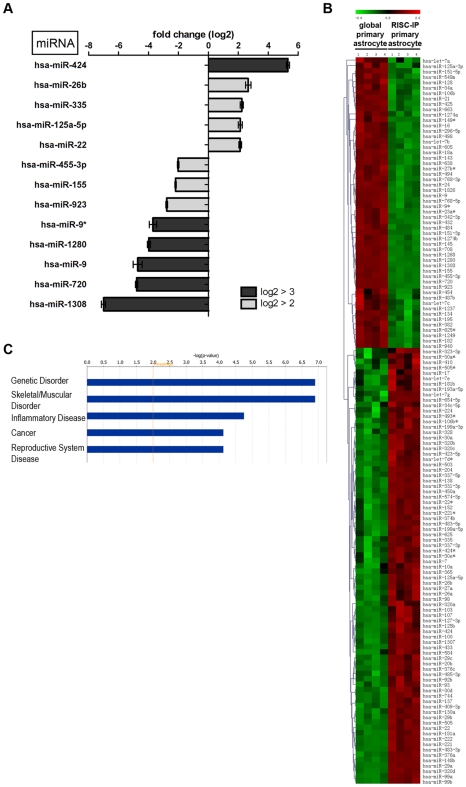
RISC-IP miRNA expression compared to global miRNA expression in primary human astrocytes.(A) MiRNAs with a log2 fold change >2 (p<0.01). MiRNAs with a positive fold change were increased in the RISC compared to the global cellular milieu in primary astrocytes and miRNAs with a negative fold change are decreased in RISC compared to the global cellular milieu in primary astrocytes. (B) Hierarchical cluster heatmap showing all significantly expressed miRNAs (p<0.01) in four independent samples/cell types. Each row shows the relative expression level for a single miRNA and each column shows the expression level for a single sample. The red or green color indicates relative high or low expression, respectively. (C) Disease/disorders associated with the miRNAs differentially expressed in RISC compared to the global cellular milieu of primary astrocytes with a Fisher's exact test p-value threshold set at 0.01 (yellow threshold line) using Ingenuity Pathway Analysis software.